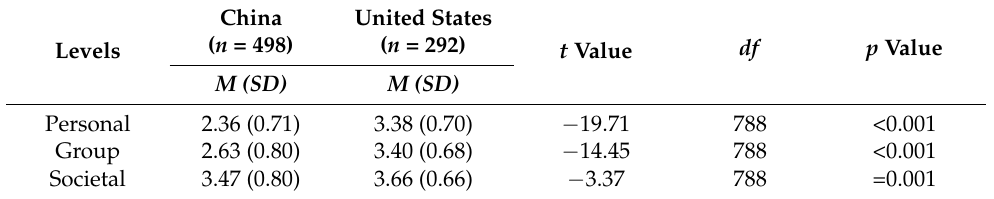
Table 3. Independent t -tests on risk perceptions at three levels between China and the United States. Levels